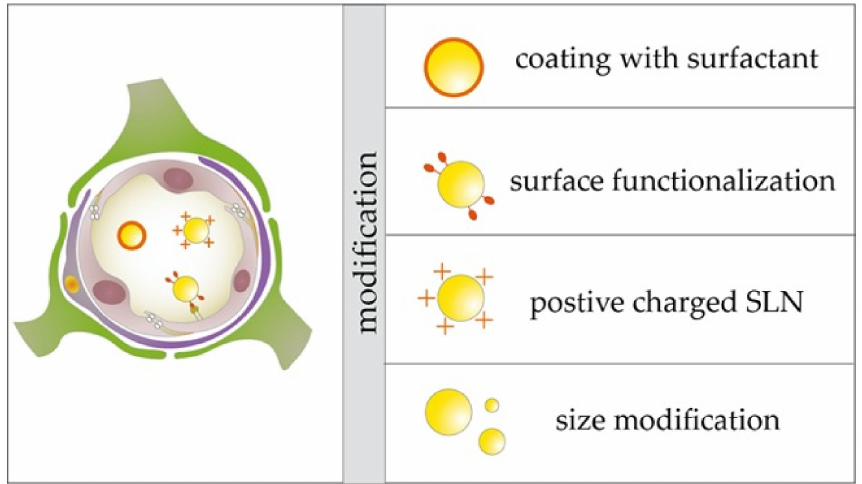
Figure 5. Methods to improve SLNs for brain drug delivery: coating with surfactant; surface functionalization; cationization; size